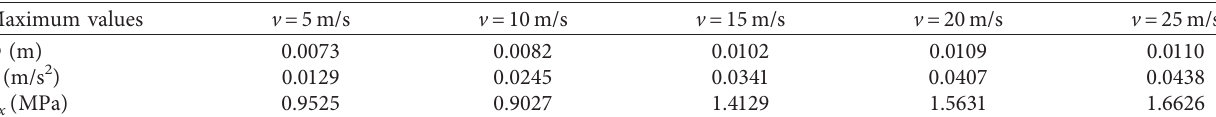
Table 6: Maximum deflections, velocities, and stress of the plate central